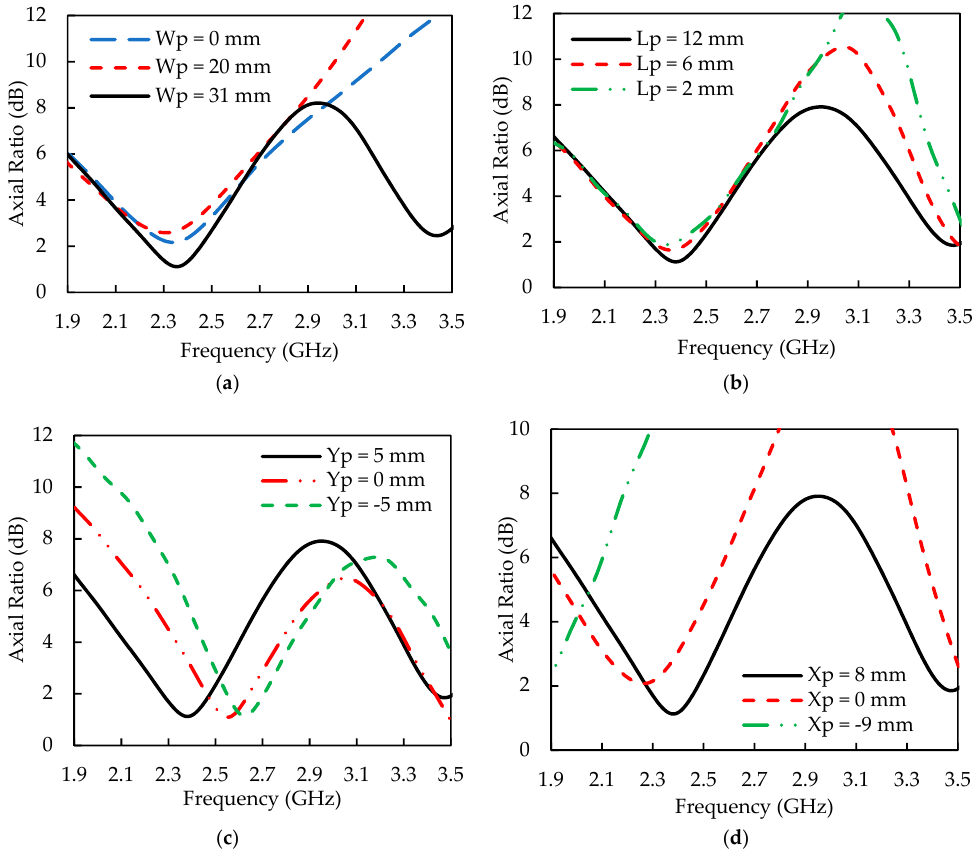
Figure 4. Variation in the axial ratio in relation to: ( a ) parasitic length L p , ( b ) parasitic width W p , ( c ) parasitic center on the y -axis Y p , and ( d ) parasitic center on the x -axis X p